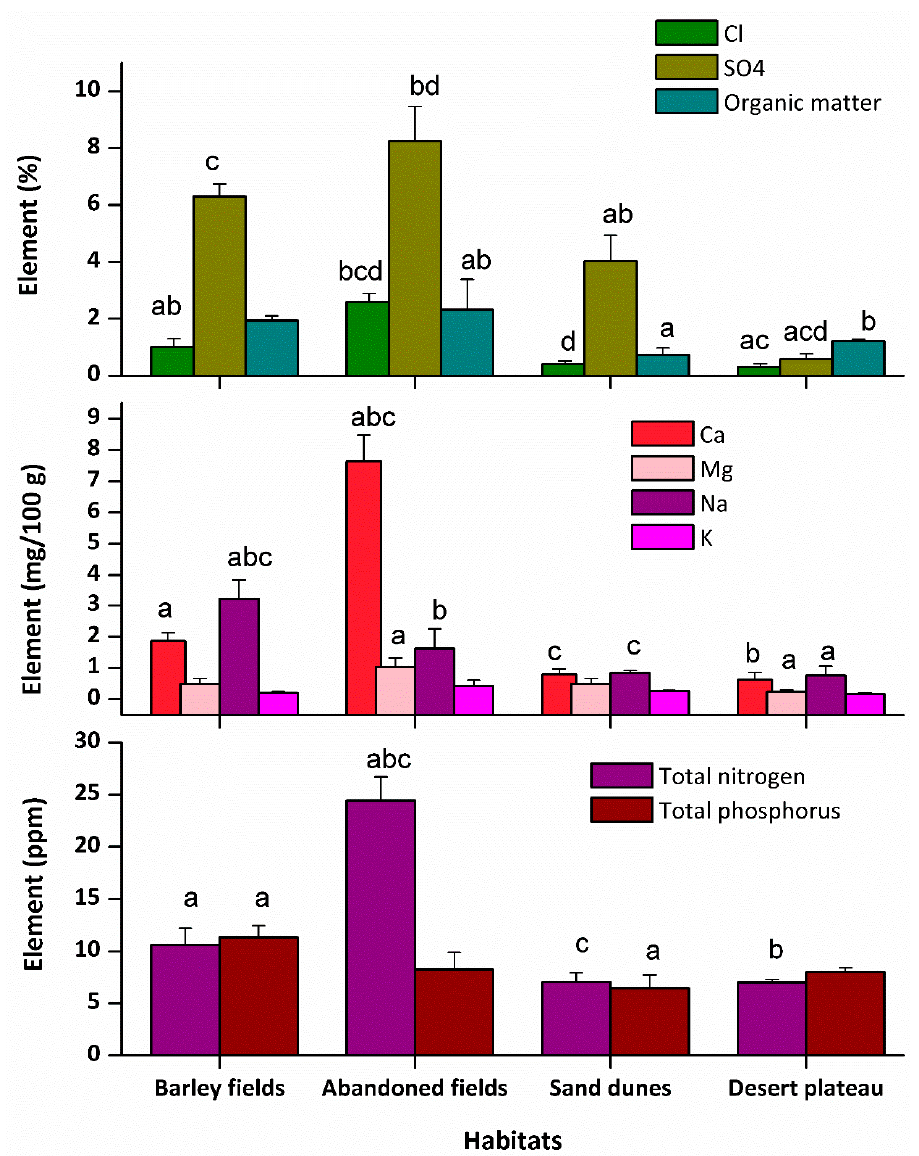
Figure1. Comparisonsofsoilvariablesatanthropogenicandnaturalhabitatsof Onopordumalexandrinum . Bars with similar letters within each soil variable are significantly di ff erent according to Tukey’s studentized range test at the 0.05 probability